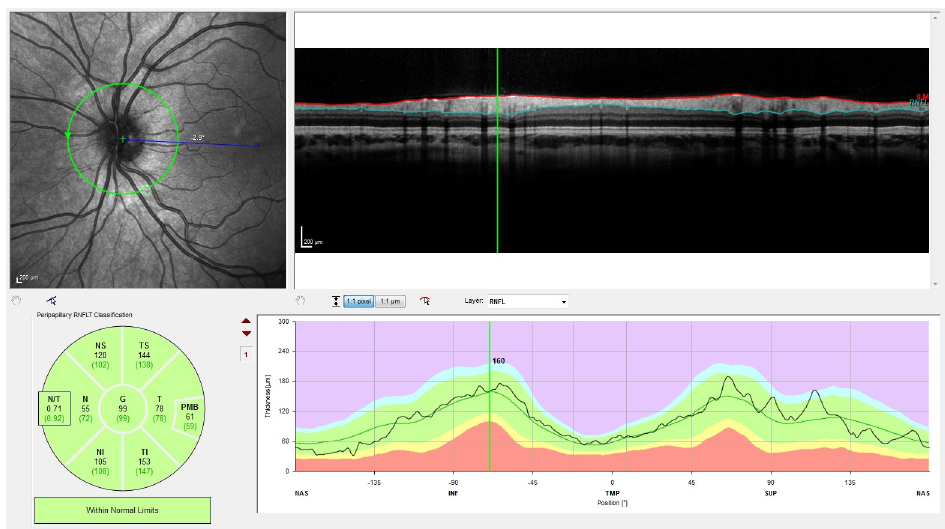
Fig 1. Exemplary peripapillary scan, oculus sinister (OS). Upper left: fundus image, upper right: OCT scan of retinal layers, lower left: RNFL values per sector (in μ m), lower right: RNFL values over the whole OCT scan with integration in normative percentiles (as set by the device for adults) and coloured areas to indicate values outside the normal range. Abbreviations: OCT–optical coherence tomography, RNFL–retinal nerve fibre layer. https://doi.org/10.1371/journal.pone.0276958.g001 The macular scan is shown in Fig 2. The resolution mode for the macular scan was a high resolution mode. The scan pattern used was 61 B-scans in a distance of 124 µ m and with an early treatment diabetic retinopathy study (ETDRS) grid size of 1, 3 and 6mm (radius). The quality parameters were set to be ART � 11 and a quality � 25. The fovea is centred (centre point) with two surrounding circles. Each circle is divided into 4 sectors: nasal (N1 / N2), tem- poral (T1 / T2), superior (S1 / S2), inferior (I1 / I2), 1 representing the inner, 2 representing the outer circle. The sector surrounding the centre point with 1mm diameter is called C0.